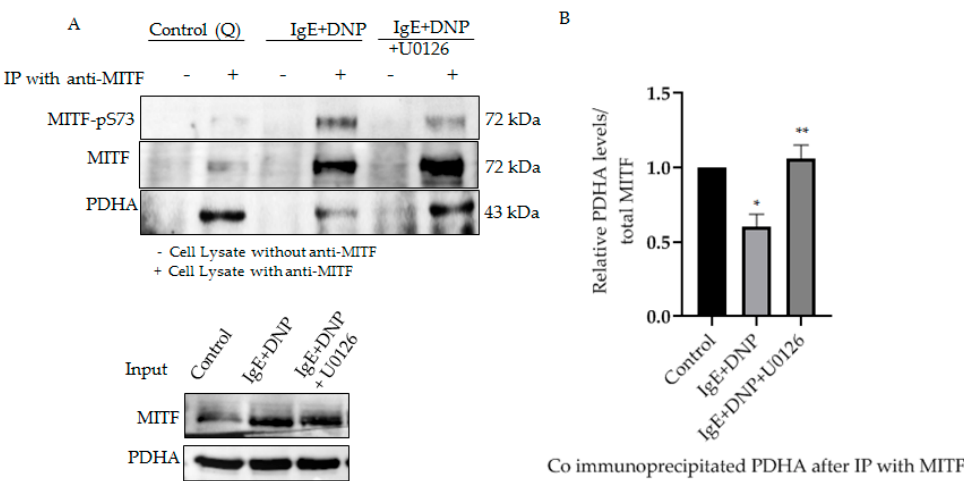
Figure 3. Serine 73 phosphorylation of MITF affects MITF-PDH interaction during mast cell stimu- lation. ( A ), IP of MITF in IgE-DNP activated RBL cell lysates in the presence and absence of ERK1/2 inhibitor. Cell lysates were pre-treated with U0126 as described in Figure 2. Non-sensitized cells are presented as Control (Q: Quiescent). For IP anti-MITF antibody was used and for Western blot analy- sis, anti-pS73-MITF, anti-MITF, anti-PDHA antibodies were used. ( B ), Densitometry of PDHA/MITF levels in RBL cells after IP experiment. A two-tailed Student t -test was performed for all the western blots. Results represent means ± SEMs (n = 4, ** p ≤ 0.01; * p ≤ 0.05; ns p > 0.05).